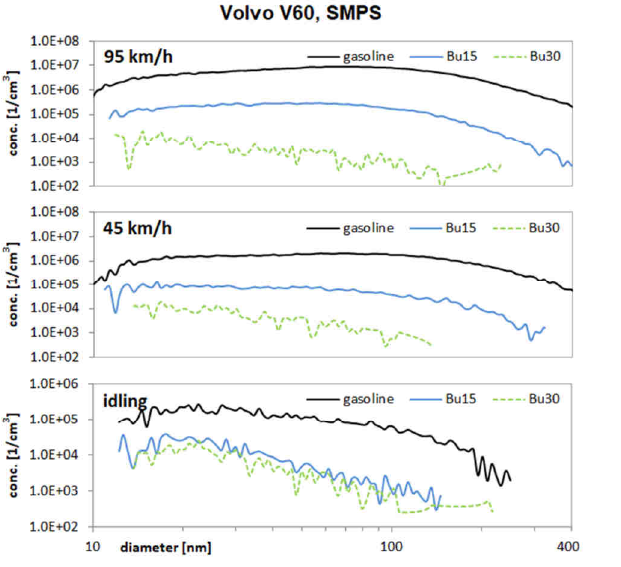
Fig. 14. Comparison of the non-legislated gaseous emissions during cold start at idling with different fuels, measured with FTIR at tailpipe